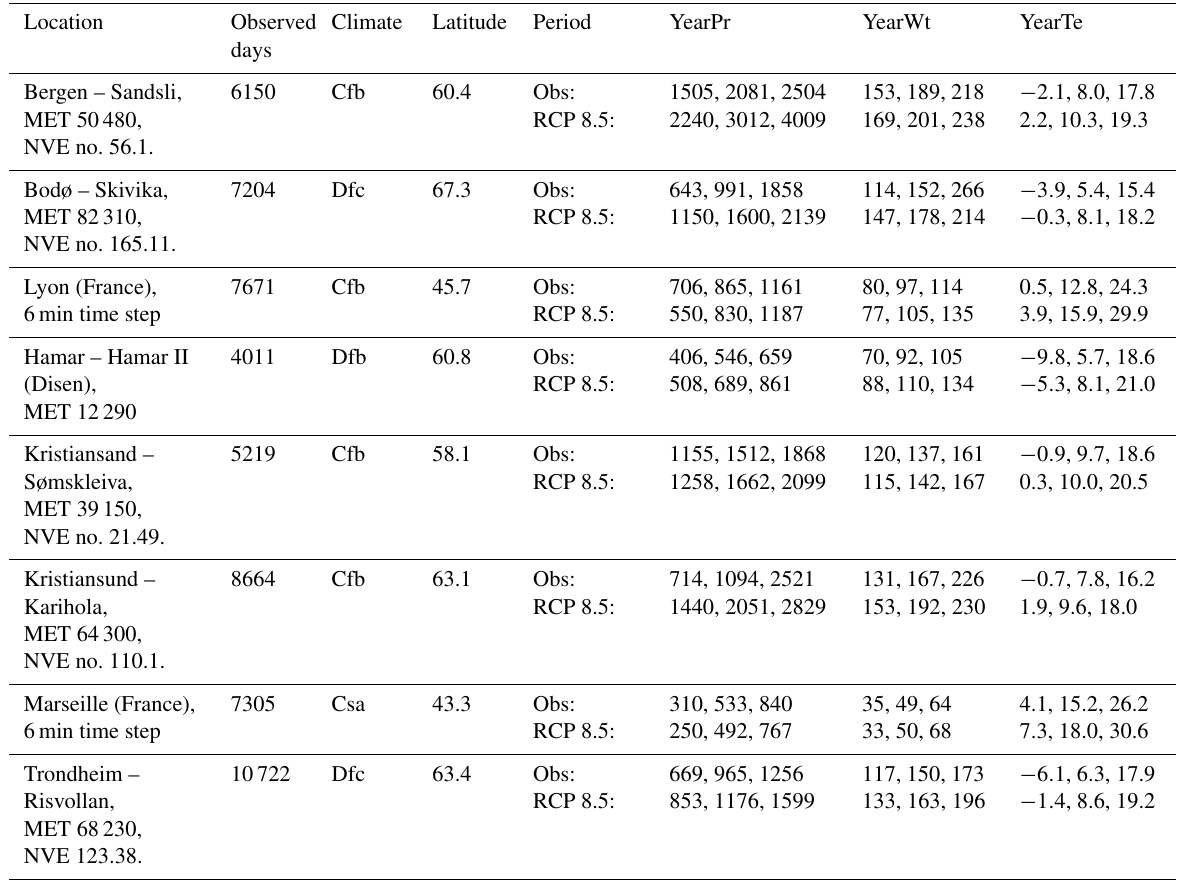
Table 1. Locations and input data for current and future climate. The climate column gives the Köppen–Geiger classification for climate. Observed days is the number of observed days with data. YearPr is the annual precipitation in millimetre, YearWt the annual number of wet days ( > 1mm). YearTe is the mean annual temperature; for these quantities the 5th, 50th, and 95th percentiles are given as